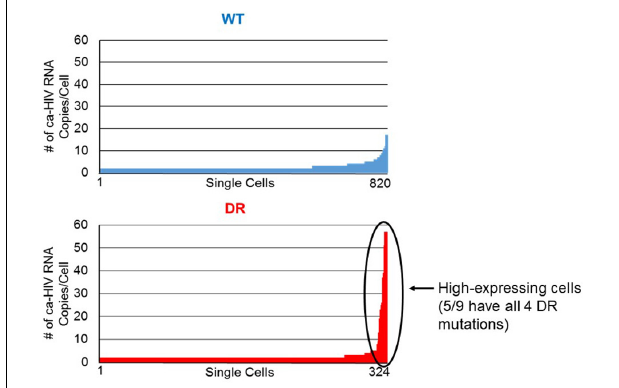
FIGURE 6 | Levels of ca-HIV RNA in single cells that carried the wild-type (blue) and drug resistant (red) proviruses. The number of ca-HIV RNA copies per cell in the wild-type population ranged from 1 to 16. The number of ca-HIV RNA copies per cell in the drug resistant population ranged from 1 to 65. Data were analyzed from 820 cells with wild-type proviruses and 324 cells with drug resistant proviruses. The remaining infected cells did not contain any detectable ca-HIV RNA. The high-expressing cells are indicated with the black